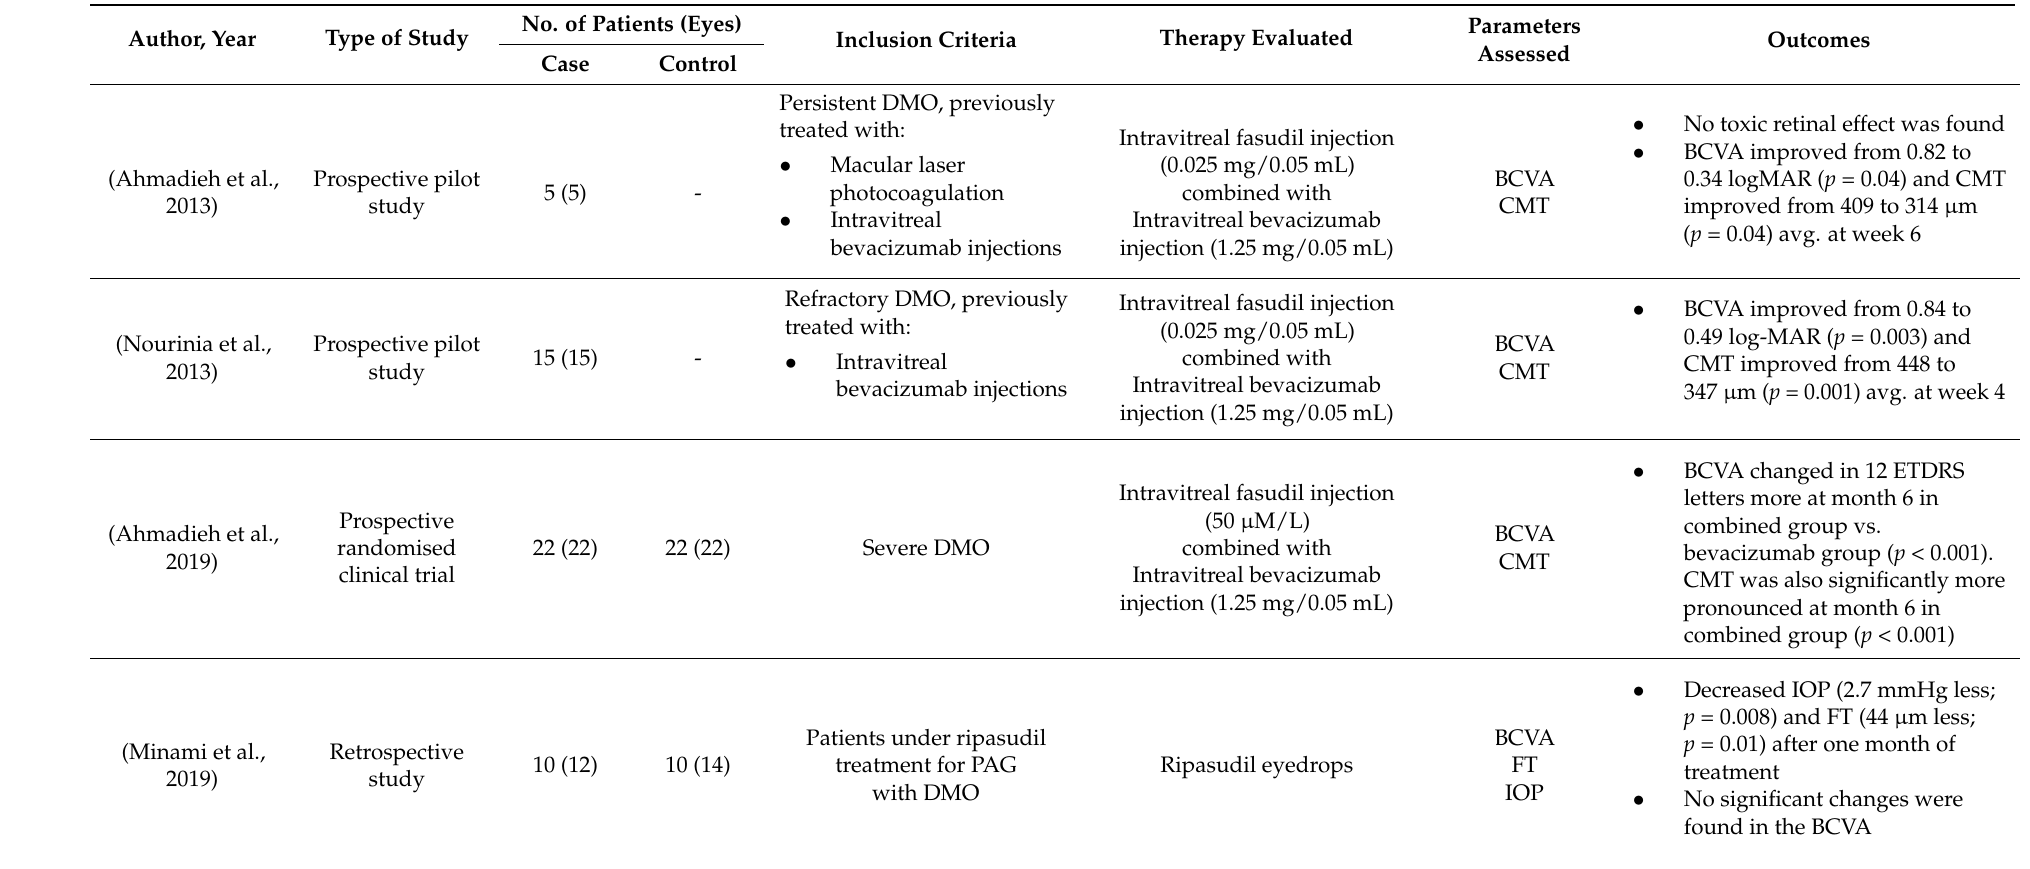
Table 2. ROCK inhibitors as a therapeutical approach in patients with DMO. Summary of clinical